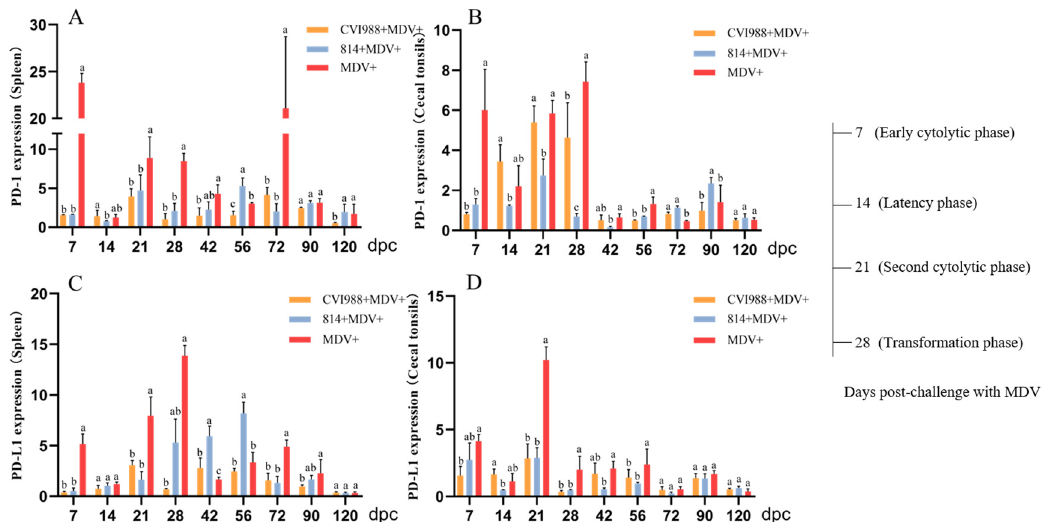
Figure 4. The mRNA expressions of PD-1 and PD-L1 in the tissues from birds experimentally infected with MDV. ( A ) PD-1 in the spleen; ( B ) PD-1 in the cecal tonsils; ( C ) PD-L1 in the spleen; ( D ) PD-L1 in the cecal tonsils. Determined by real-time PCR. Means not sharing a common letter are significantly different ( p < 0.05).